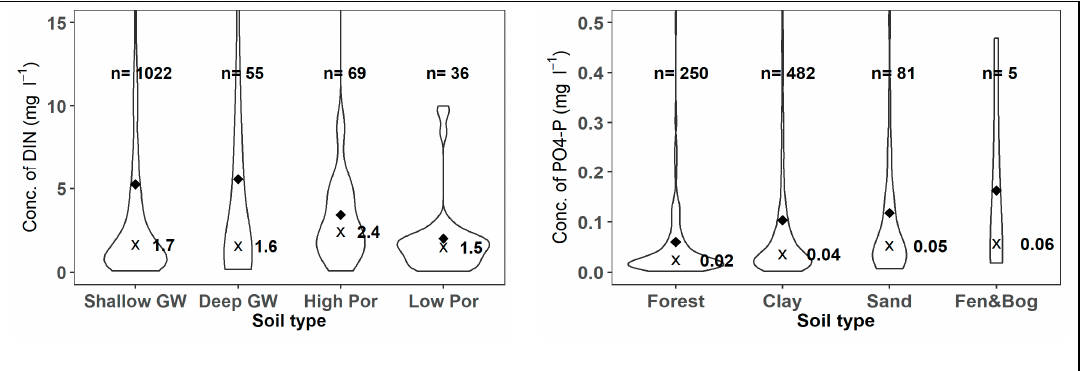
Figure 6. Kernel density plot showing the distribution of the measurements of dissolved inorganic nitrogen ( left ) and orthophosphate ( right ) concentrations measured in groundwater wells. Diamond: mean value, x: median value.